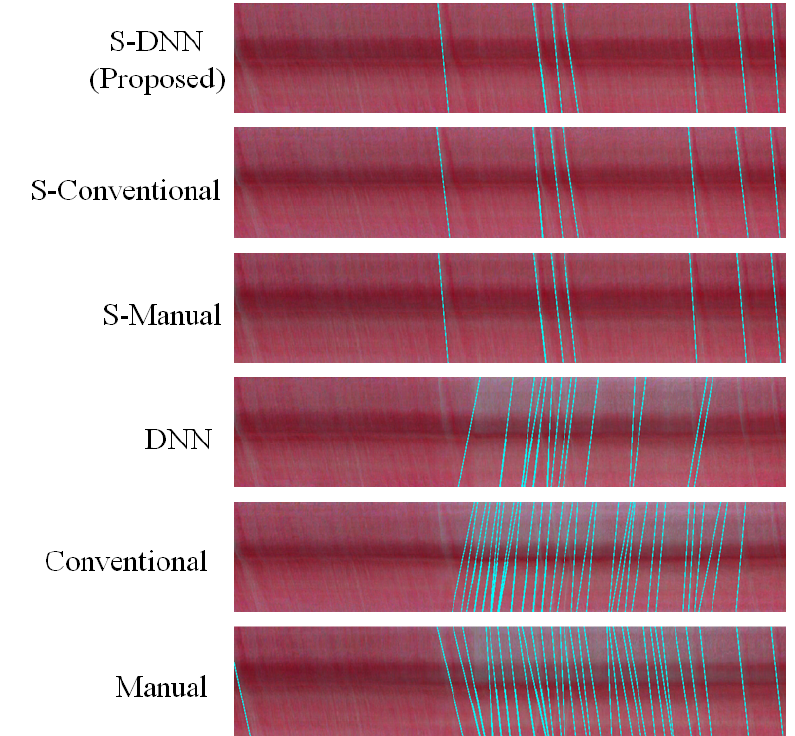
Figure 8. ST maps and reconstructed events (cyan lines) for ST maps detected by event counting for the combinations of video stabilization and capillary segmentation for capillary